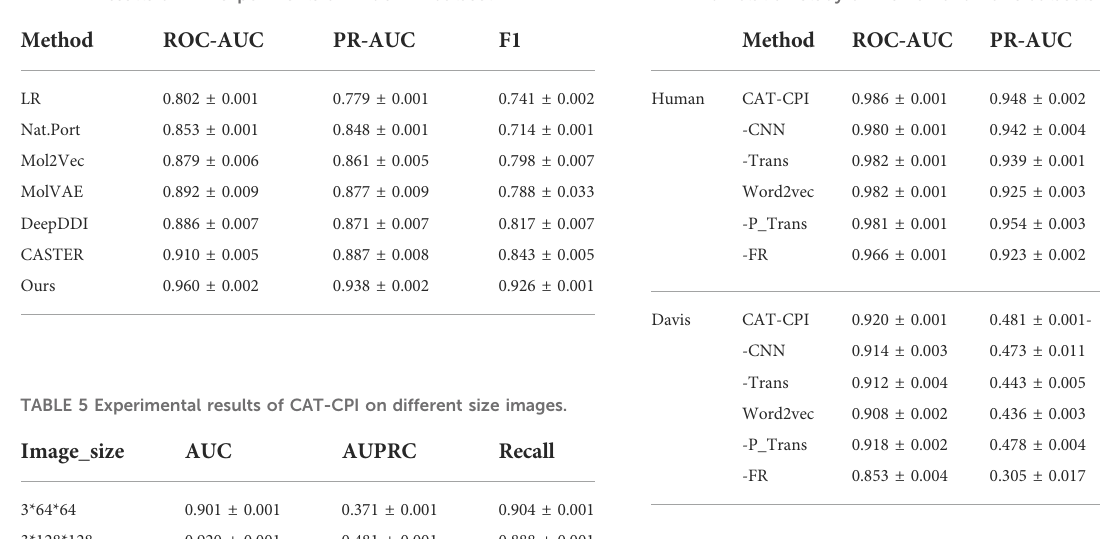
TABLE 6 Ablation study on Human and Davis